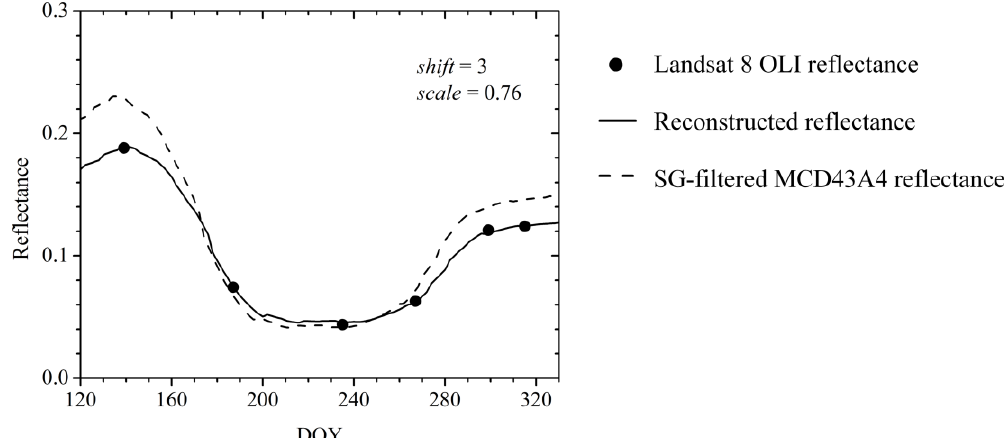
Figure 4. Illustration of the CACAO fitting of the MODIS phenology model to actual Landsat observations for reconstructing high spatiotemporal reflectance data. Case of reflectance in the red band for the central pixel of the study area. The shift and scale fitting parameters are indicated.